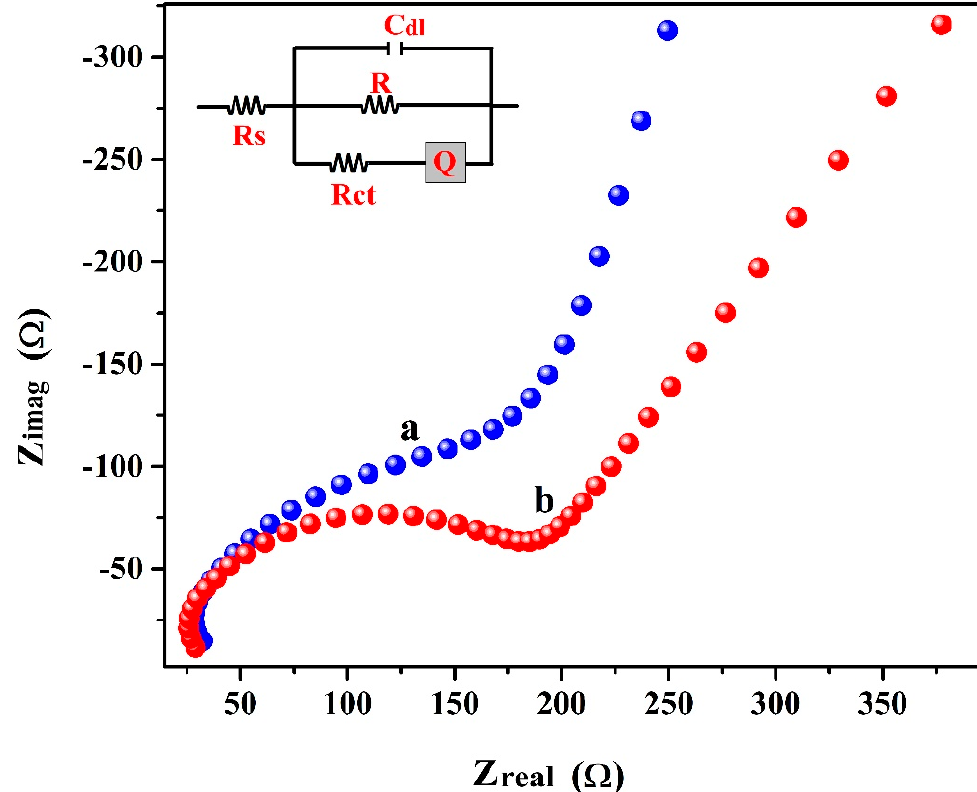
Figure 2. E IS curves for BCNTPE (curve-a) and P(PAN)LCNTPE (curve-b). Figure 2. EIS curves for BCNTPE (curve-a) and P(PAN)LCNTPE Table 1. EIS results for BCNTPE and P(PAN)LCNTPE.